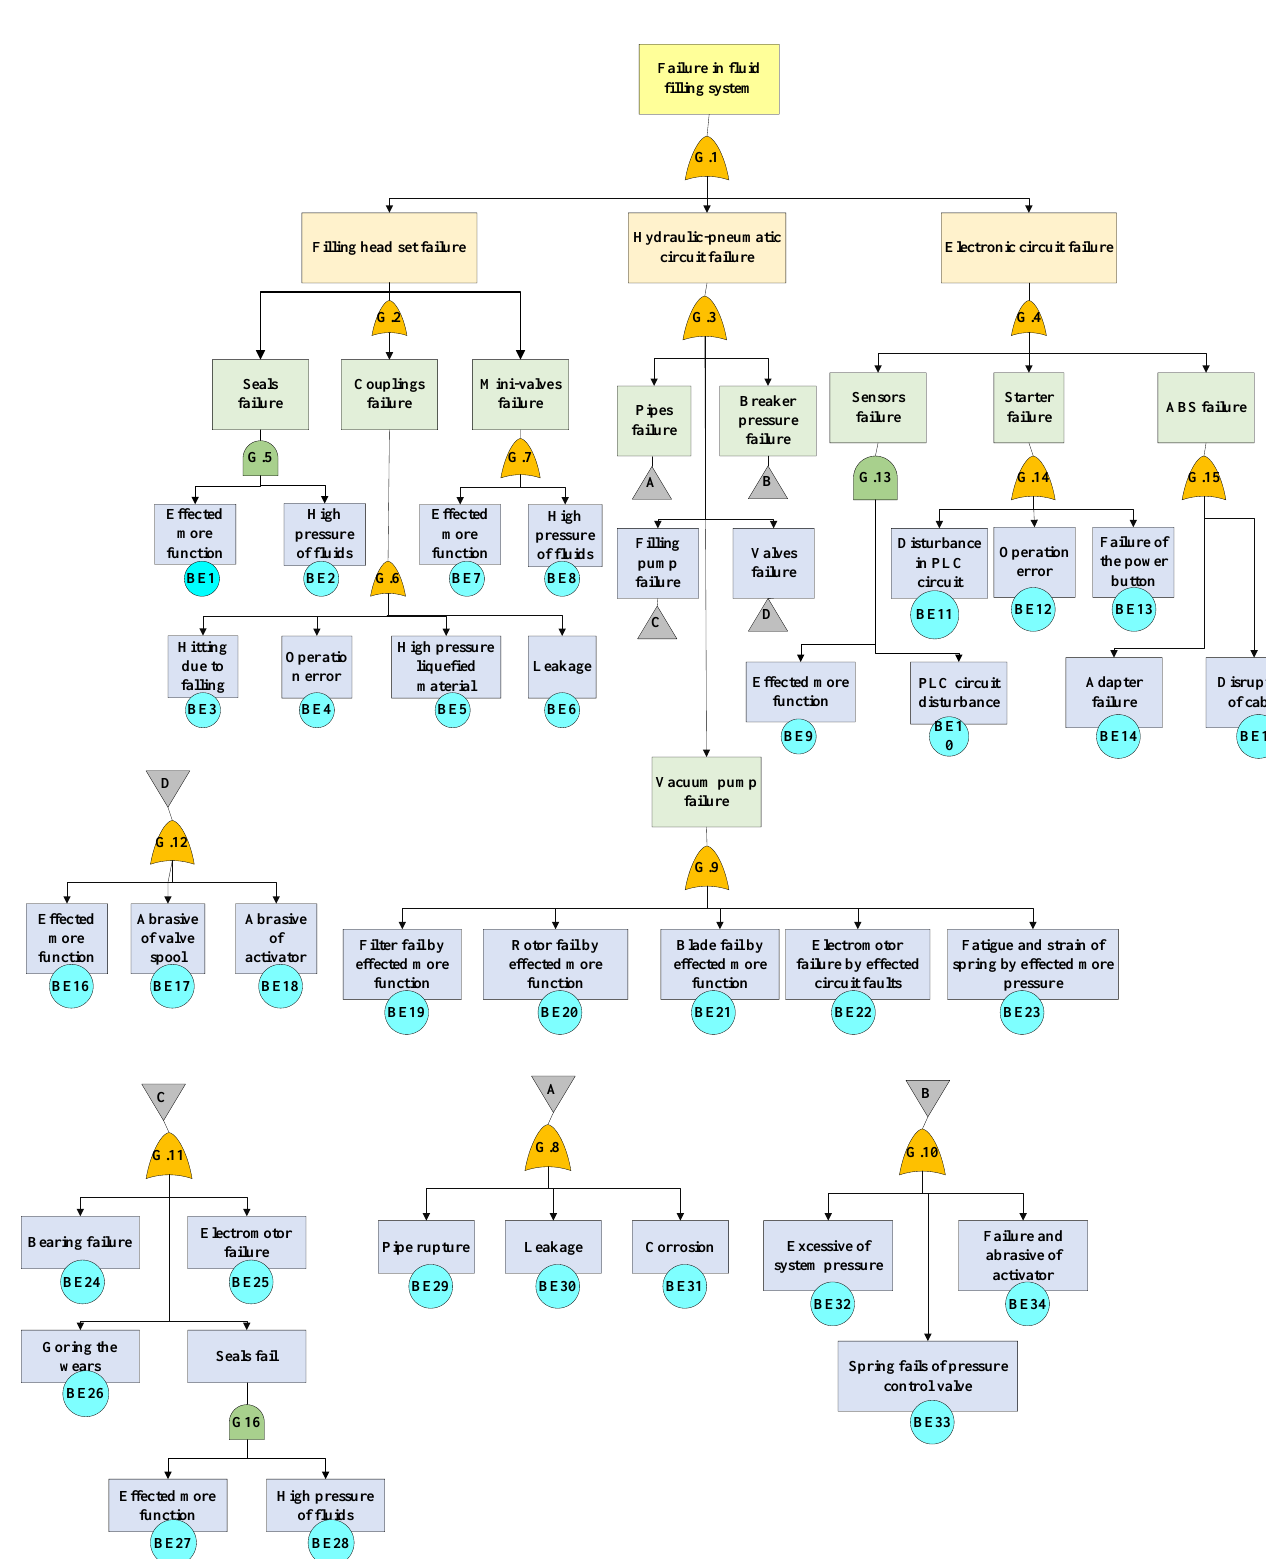
Figure 3. The FTA structure for the failures in a complex filling system in an Iranian automotive production line.